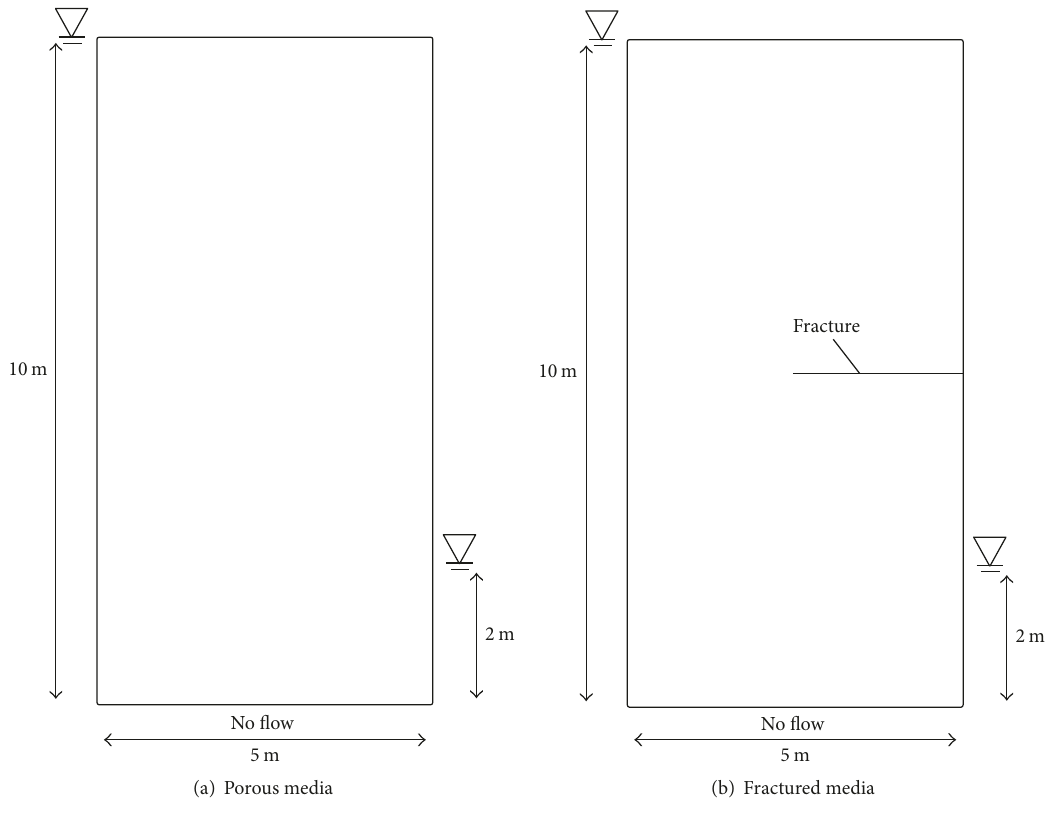
Figure 10: Dimensions and boundaries of the dam